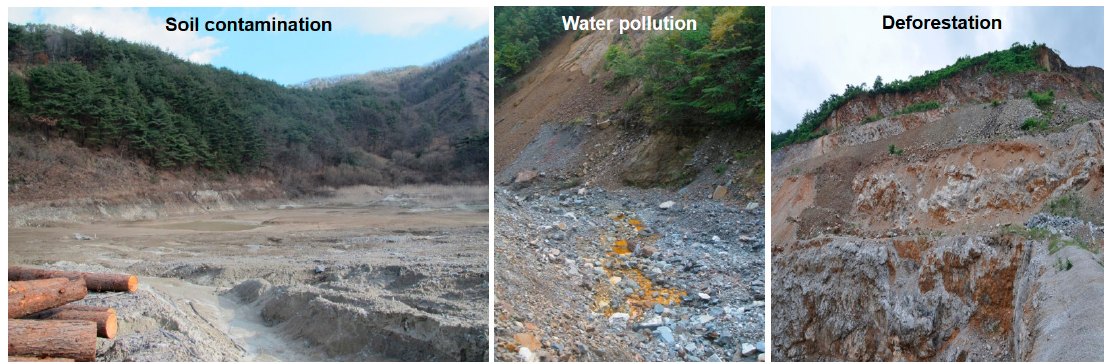
Figure 1. Photographs of representative mining ‐ induced hazards associated with soil (Samgwang mine, Korea), water (Gagok mine, Korea), and forest (Ssangyong limestone mine, Korea). All three photographs were taken by the authors.